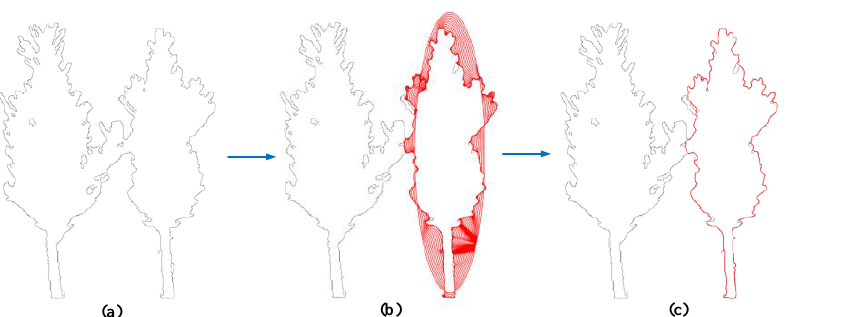
Figure 11. The process of individual tree segmentation when tree projections overlap. ( a ) Two trees overlap after projection, ( b ) the iterative process of Snake algorithm to extract the edge, ( c ) the red curve is the extracted edge of the individual tree.